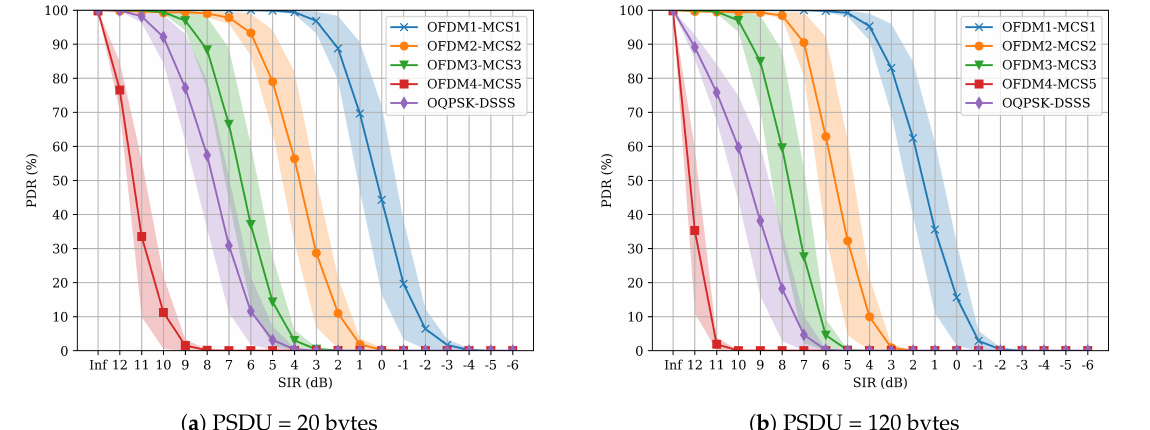
Figure 8. OFDM4-MCS5 interference results.